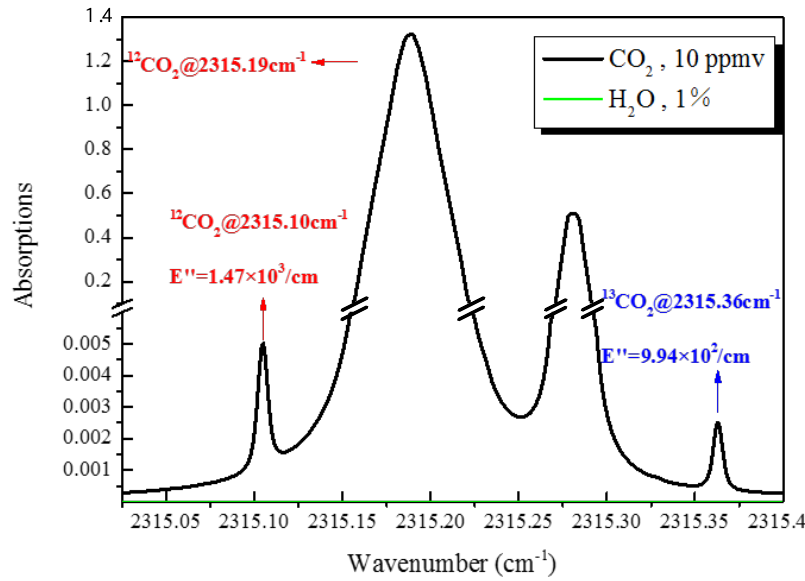
Figure 1. The high-resolution transmission (HITRAN) absorption spectra of 10 ppmv CO 2 and 1% H 2 O at a gas pressure of 20 Torr with a 24-m effective optical path length.